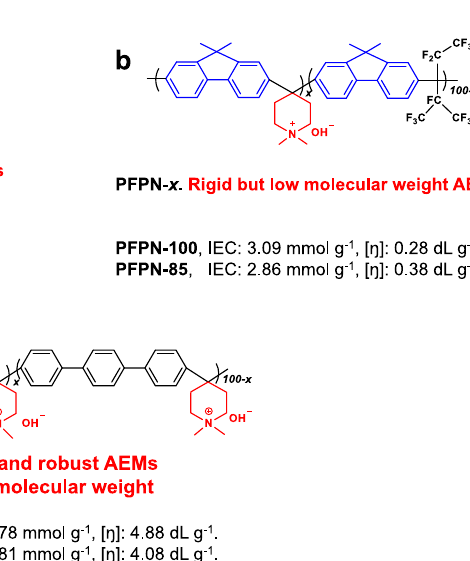
Fig. 1 The chemical structure of representative polyelectrolytes with IEC and intrinsic viscosity. a PFBP- x , b PFPN- x , and c PFTP- x